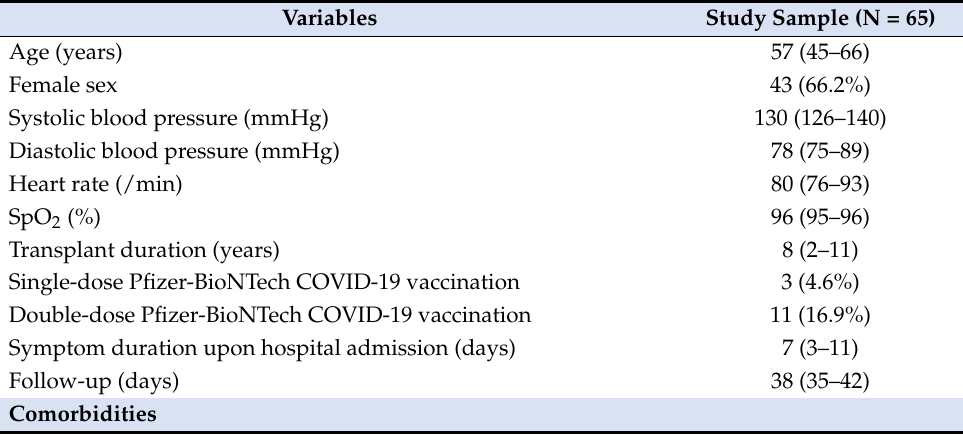
Table 1. Baseline characteristics of the study